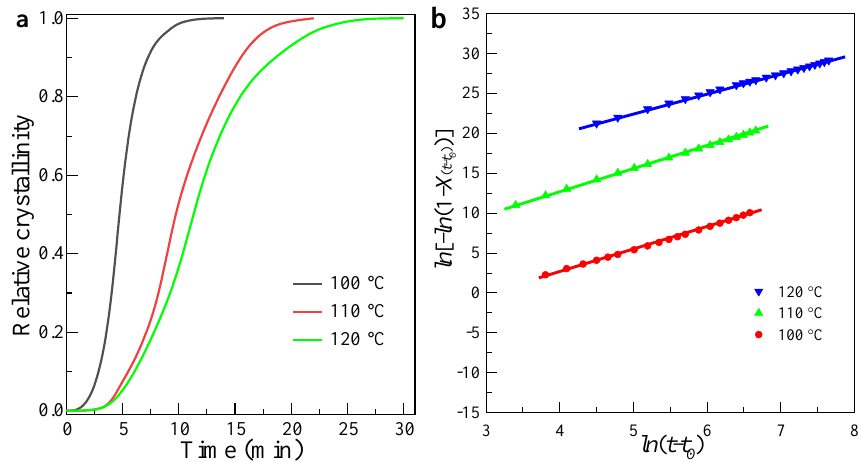
Figure 7. ( a ) Relative crystallinity vs. time ( t − t 0 ) of PLLA. ( b ) Double logarithmic plot of amorphous content versus ln ( t- t 0 ) (sample crystallized isothermally at 100 °C, 110 °C and 120 °C, respectively). Table 2. Isothermal crystallization parameters of